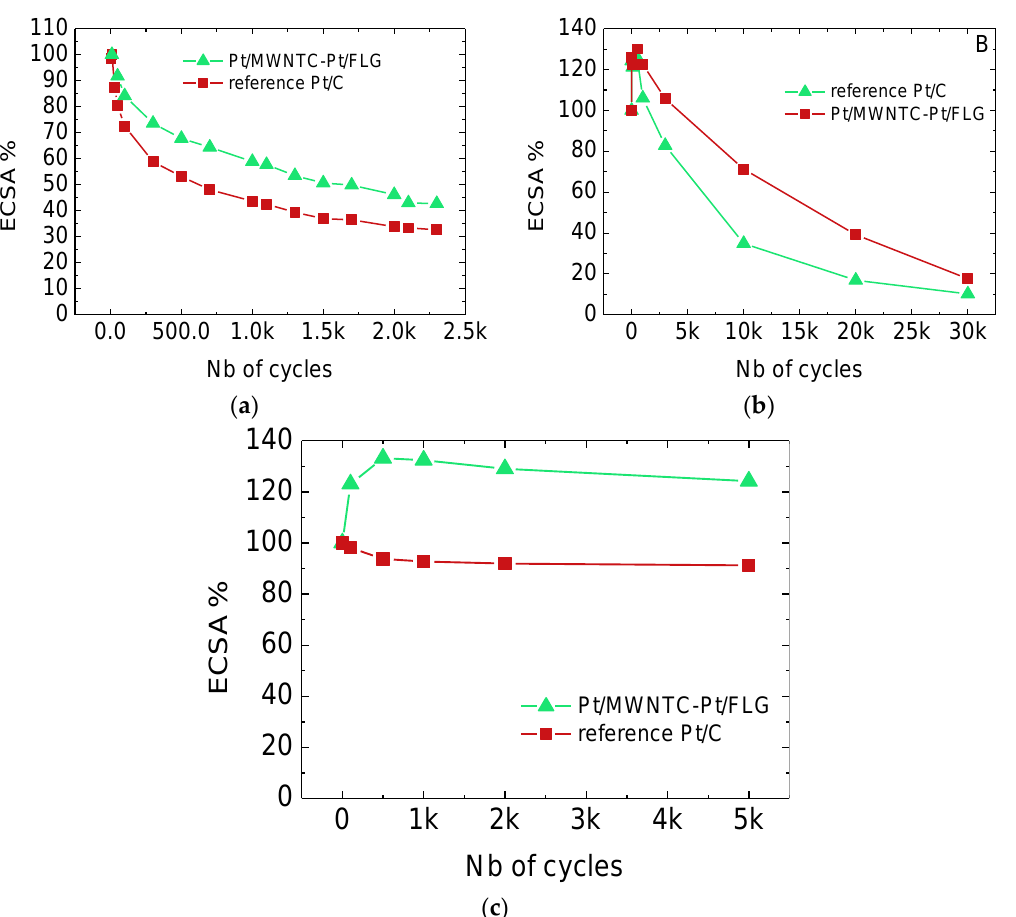
Figure 4. ( a ) CV from 0.3 to 1.18 V Vs RHE with a scan rate of 20 mV · s − 1 ( b ) CV from 0.6 to 1.0 V Vs RHE with a scan rate of 50 mV · s − 1 and ( c ) CV from 1.0 to 1.5 V Vs RHE with a scan rate of 500 mV · s − 1 .